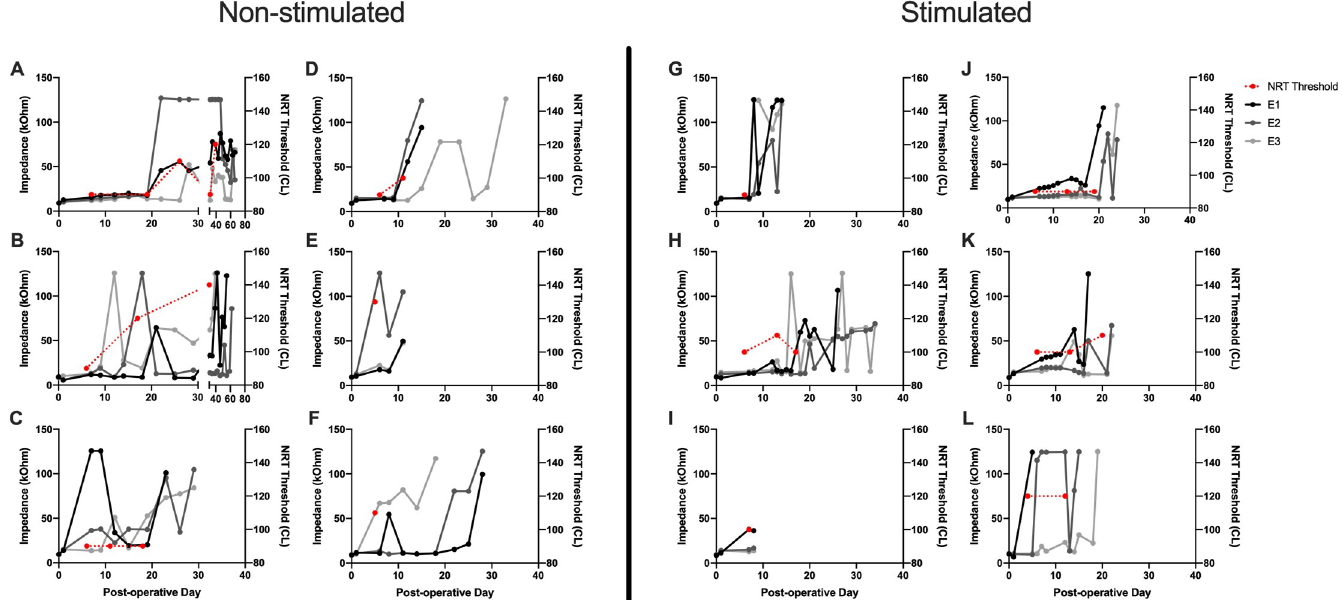
Fig 6. Serial impedance and NRT threshold values over time. Individual subject impedance values per electrode and NRT threshold are plotted over time. A-F represent individual data for the non-stimulated subjects and G-L for the stimulated subjects. Day 0 represents impedance values obtained immediately prior to implantation. NRT threshold values (red) are scaled to the right sided y-axis. Impedance values are in grayscale and scaled to the left sided y-axis. The most basal electrode (E1) is black, middle electrode (E2) dark gray and most apical electrode (E3) light gray. Impedance levels of 125 kOhms represent the measurement limit of the system.